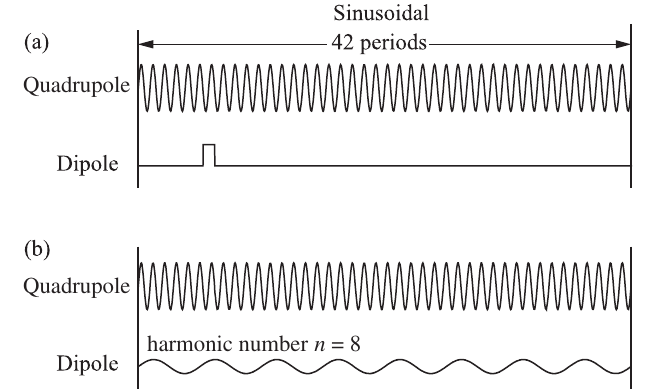
FIG. 3. Typical waveforms of the driving rf voltages applied to the LPT electrodes. The doublet focusing is approximated by a sinusoidal waveform oscillating at 1 MHz. As for the dipole perturbation, two different rf waveforms are considered, namely, (a) a piecewise constant voltage emulating the local dipole field error such as a leakage field from the septum magnet in EMMA and (b) a sinusoidally varying voltage corresponding to a single Fourier harmonic of the pulse voltage in